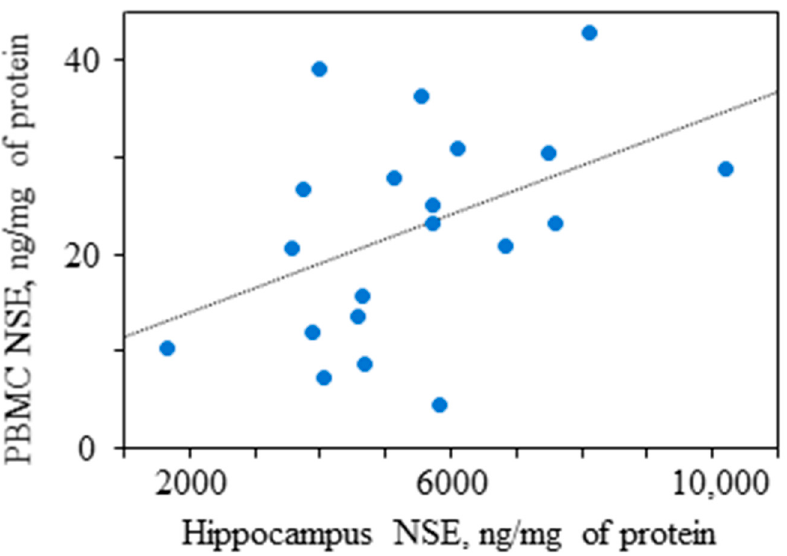
Figure 2. Correlation for concentration of NSE (corrected by total protein) between the hippocampus and PBMCs in 20 operated epileptic patients ( r = 0.45, p = 0.047 , Pearson test). NSE concentration was measured using ELISA with Vector-Best kits (Novosibirsk, Russia). The regression line is shown.